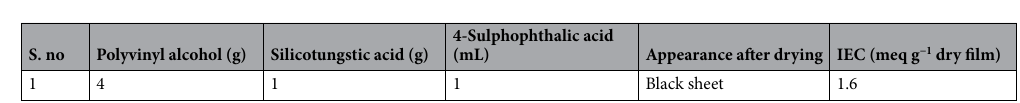
Table 1. Condition of preparation and ion exchange capacity of SA/SPVA composite cation exchanger material.